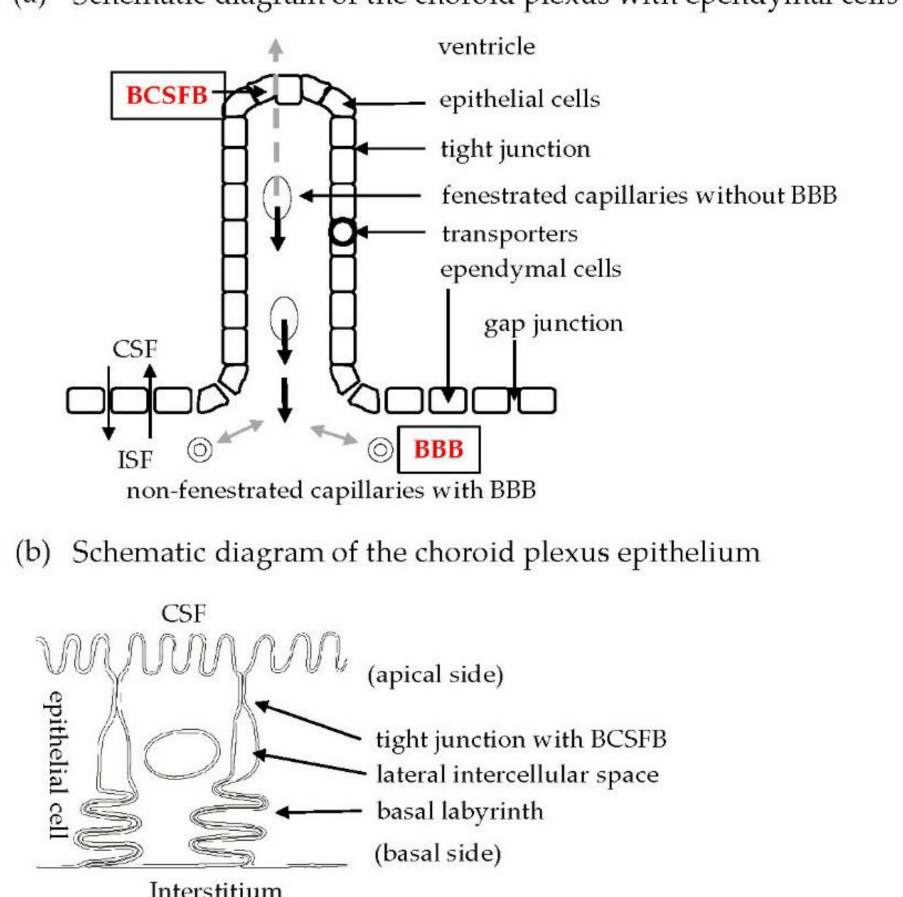
Figure 1. ( a ) Schematic representation of BCSFB in CPE cells. Fenestrated capillaries are located in the stroma of CP. CPE cells facing the ventricle are bound by tight junctions. Ependymal cells mainly bound by gap junctions are located between the ventricle and brain parenchyma. Transporters are localized in the cytoplasmic membrane of CPE cells. Non-fenestrated capillaries with tight junctions between endothelial cells are situated in the brain parenchyma and have a tight barrier function, referred to as the blood–brain barrier (BBB). ( b ) Schematic diagram showing localization of the tight junction, lateral intercellular space, and basal labyrinth on the lateral side of CPE